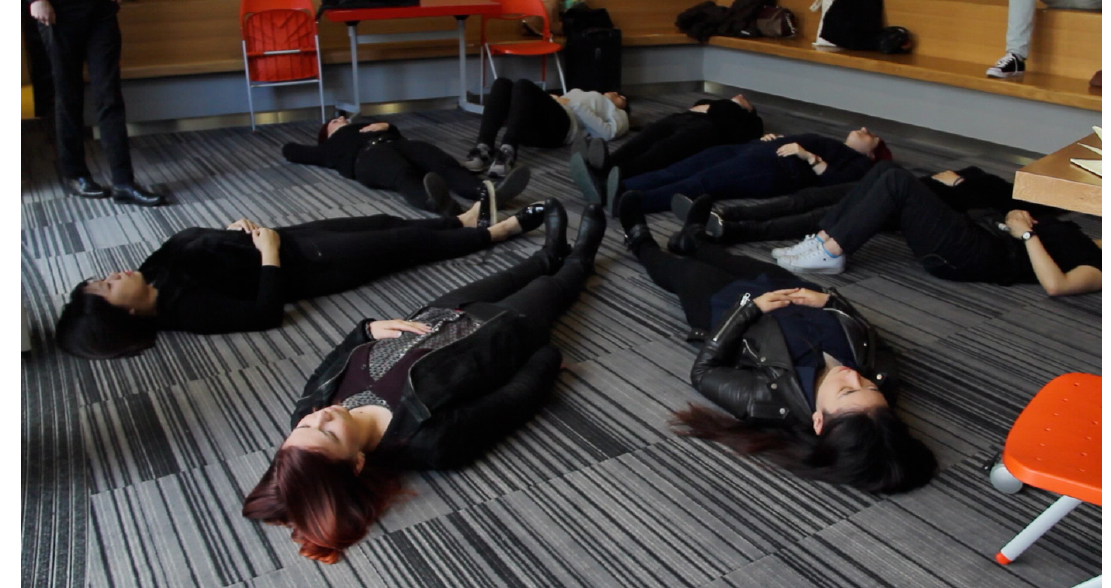
Figure 3. Video still of rehearsal (breathing exercises) at the Library of